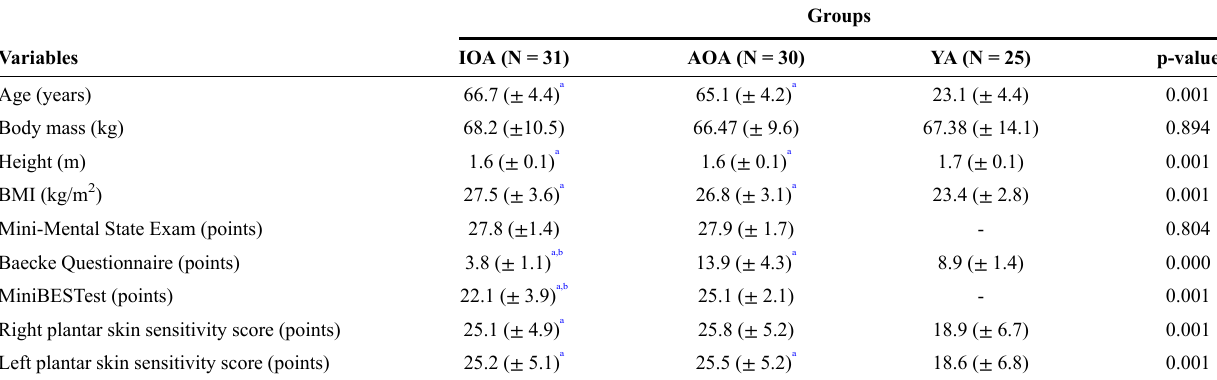
Table 1 - Mean and standard deviation (in parenthesis) for the age and anthropometric and clinical characteristics of active older adults (AOA), inactive older adults (IOA), and young adults (YA). P-values indicate significant